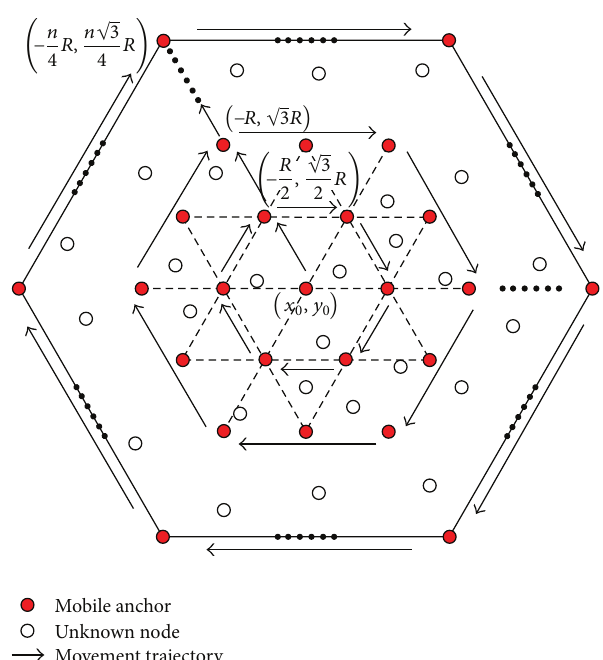
Figure 5: Movement trajectory of MAALRH without a boundary compensation